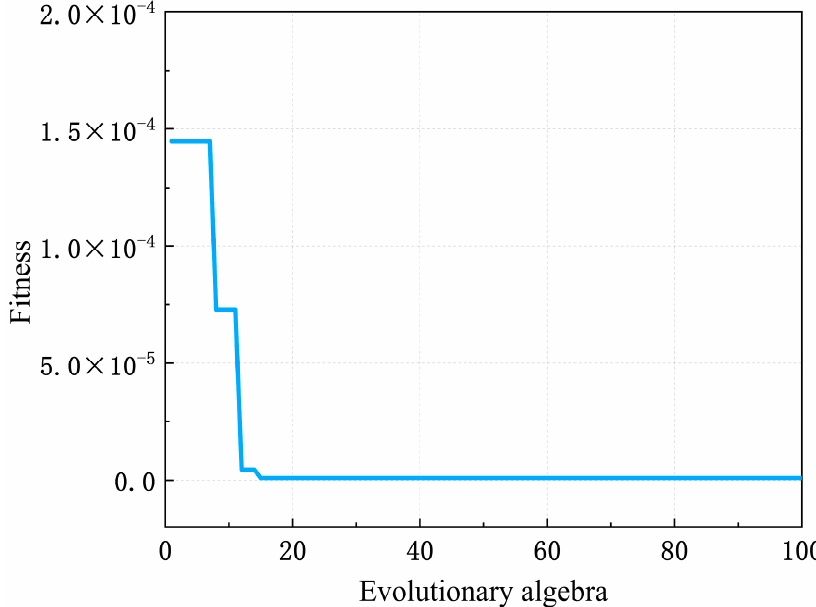
Figure 6. Curve of fitness and evolutionary algebra (parameter c1 = 1.5 c2 = 1.5 termination algebra = 100).